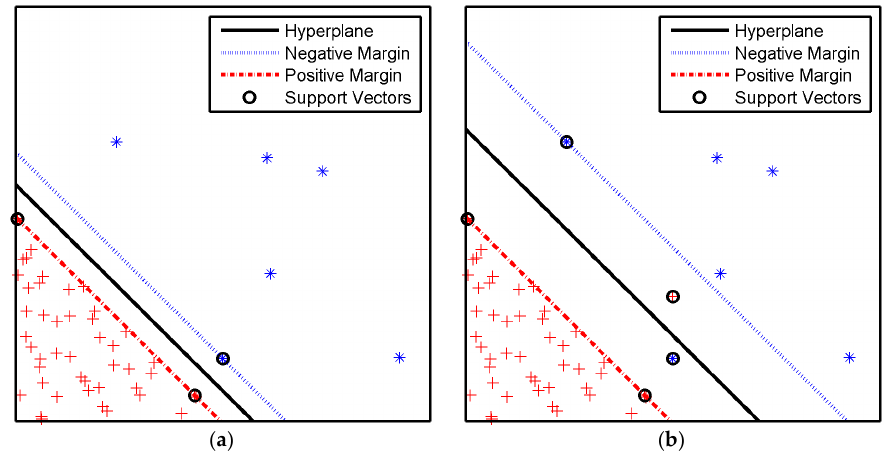
Figure 1. The effects of noise of majority class: ( a ) without noise; and ( b ) with noise.